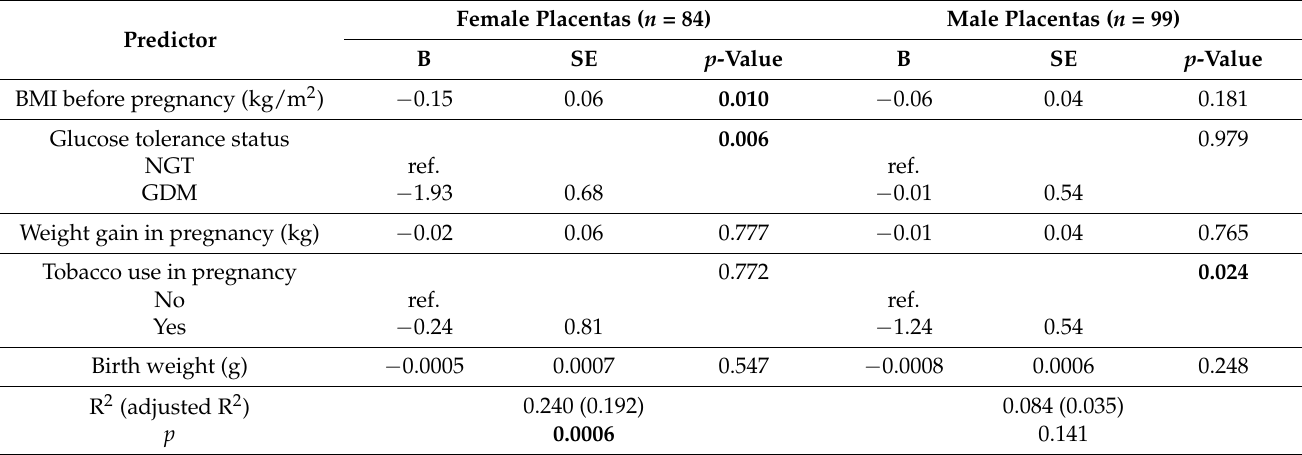
Table 2. Linear regression model of L1 methylation (%) predictors in female and male placentas. Predictor